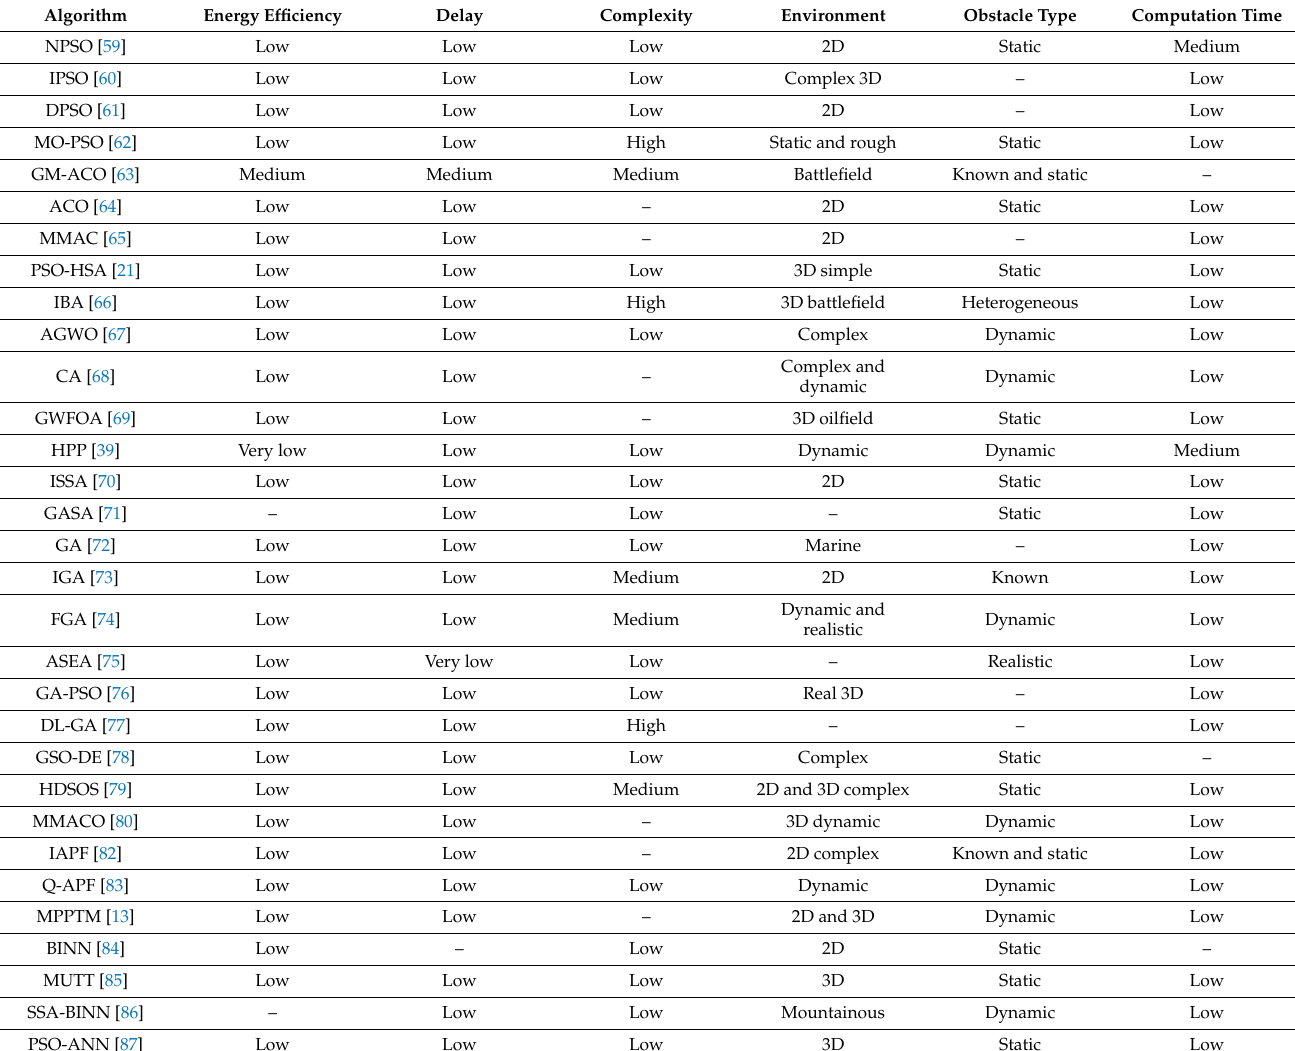
Table 5. Comparison of the bio-inspired algorithms in terms of key operational